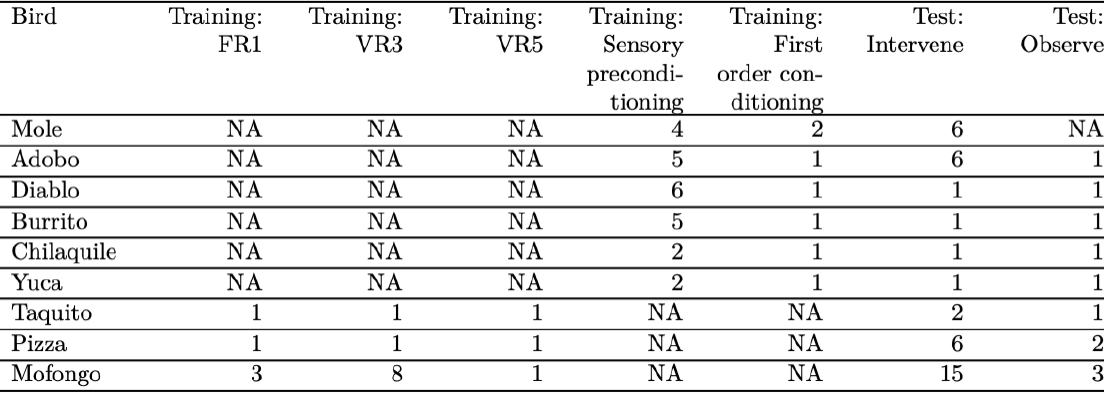
Table 5. The number of sessions it took for each bird to complete each training and test program. Ideally, each program is completed in one session. Trials were initiated manually only when the grackle was attending to the screen. Therefore, the more sessions required to complete a program indicates the grackle was attending less to the screen. The training programs changed part of the way through the experiment, therefore NA indicates the training type was not conducted for that bird (see protocol below for details). Additionally, Mole was not given the observe test because he had to be released from the